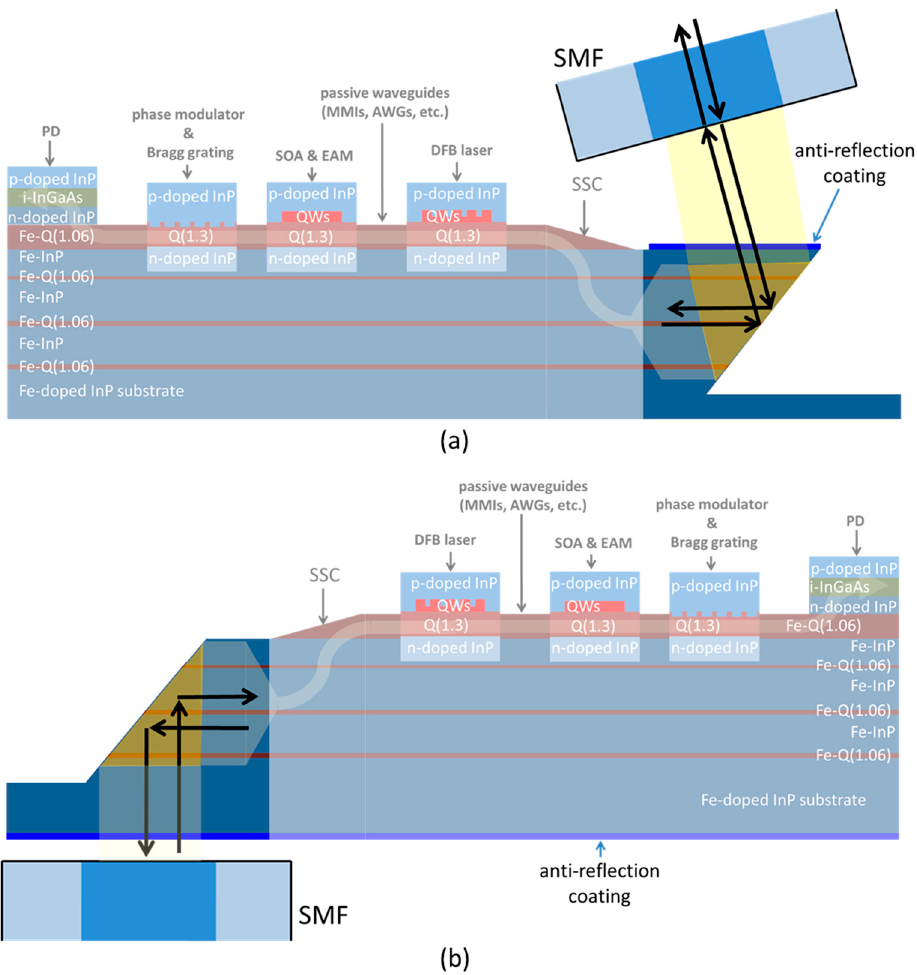
Figure 10. Schematic showing the implementation of vertical mirrors on the generic-foundry-service process for coupling light upward ( a ), and downward ( b ).